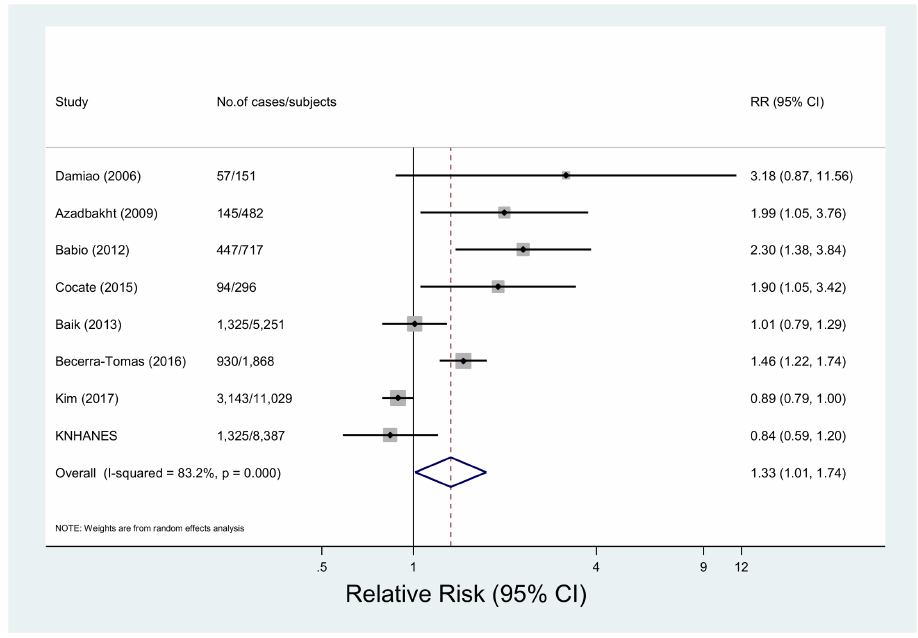
Figure 3. Forest plot of observational studies of metabolic syndrome for the highest vs. lowest levels of red meat consumption, using a random-effects